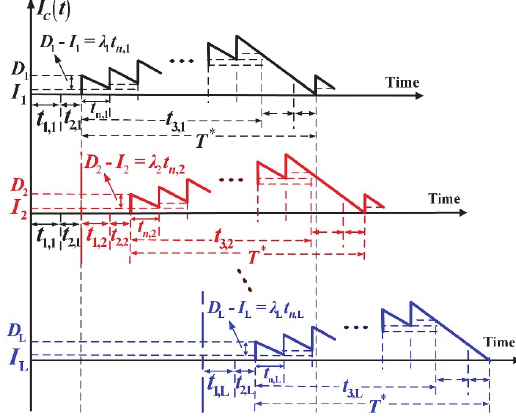
Fig. 5. On-hand inventory level of customized end products at the customer’s side during the production